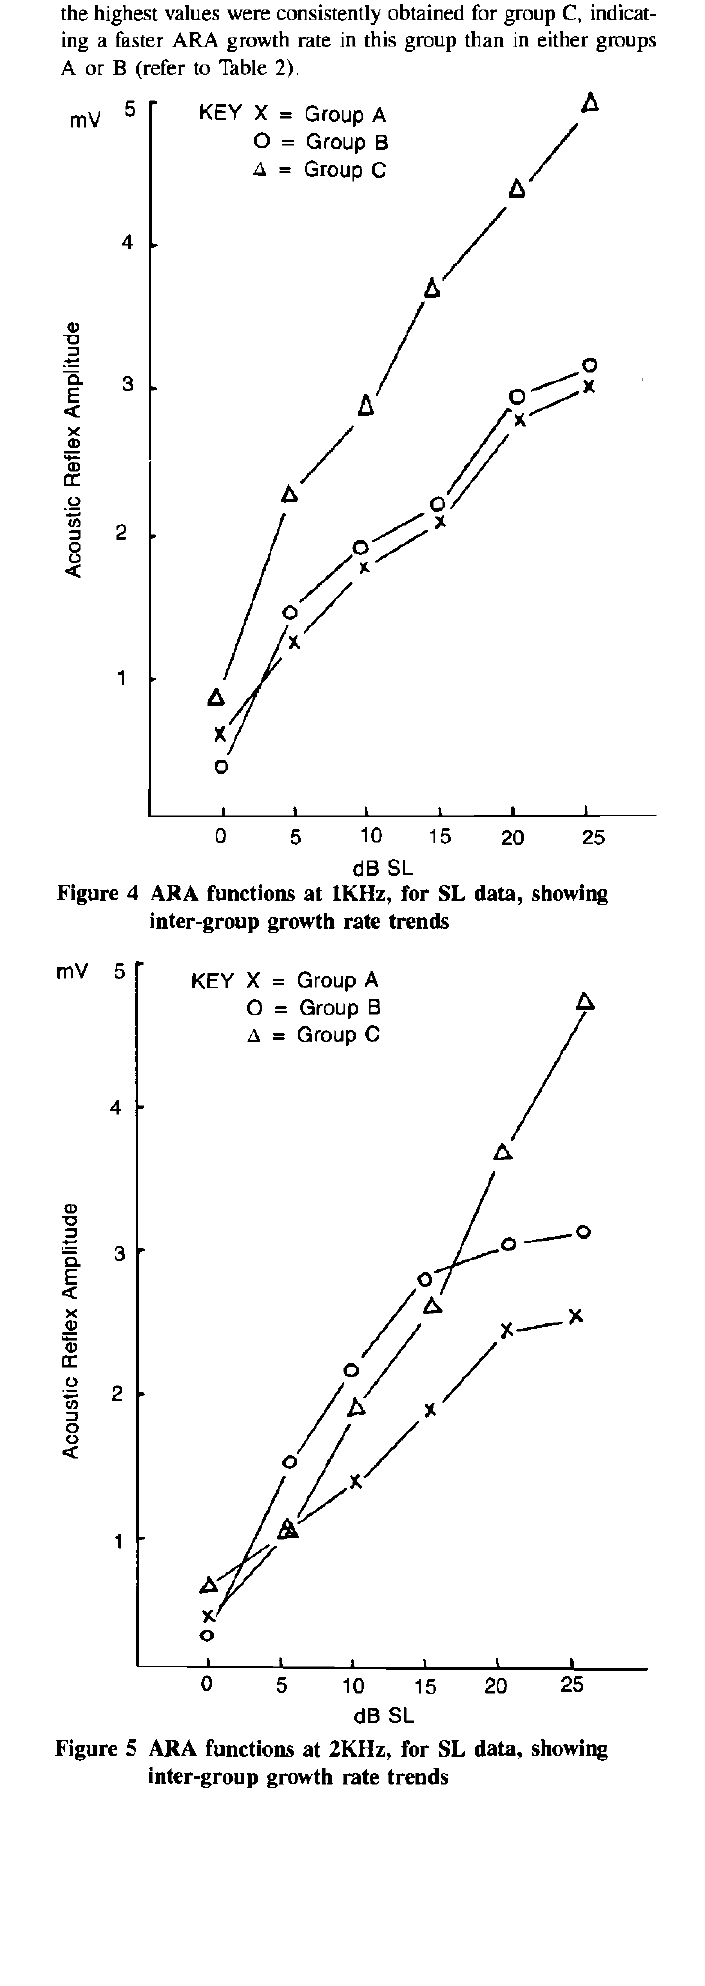
Die Suid-Afrikaanse Tydskrif vir Kommunikasieafwykings, Vol. 32,